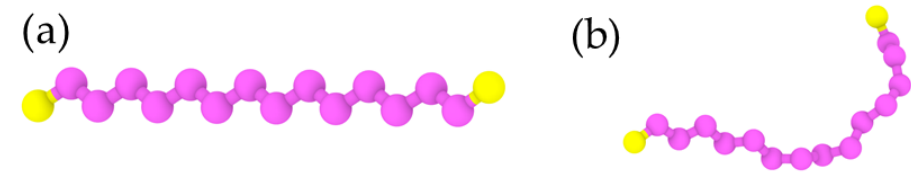
Figure 2. Schematic of one hexadecane molecule’s ( a ) initial structure and ( b ) after the optimization of conformation. The pink and yellow atoms indicate the united atoms of CH 2 and CH 3 .